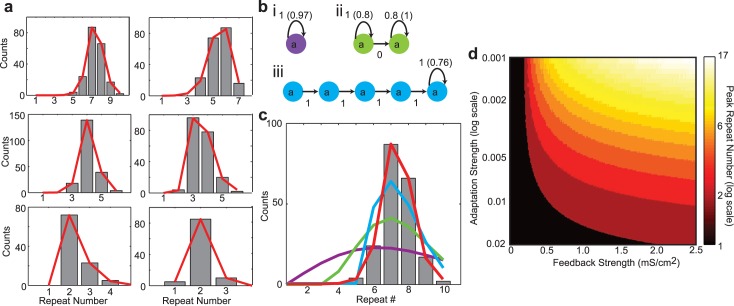
Sigmoidal adaptation model of repeats and model predictions.a: Six example repeat count histograms (black bars) from the neural network simulations with adapting auditory feedback and the best fit distributions from the sigmoidal adaptation model (red lines). The decay constants of the auditory feedback and the syllable lengths are varied to produce different repeat number distributions. Syllable lengths are changed by altering the number of groups per chain. All fit errors are smaller than benchmark errors. b: Best fit geometric adaptation models for the first histogram in a. With geometric adaptation, the probably of a state repeating is decreased by a constant factor with each consecutive repeat (Materials and Methods): (i) single state; (ii) two-states, both repeating; (iii) multiple-states, only final state repeating. In all cases, numbers on arrows are initial transition probabilities while the number in parenthesis is the constant adaptation factor. c: Comparison of model fits. Red is the best fit of the sigmoidal adaptation model with one state. Other colors are best fits of the corresponding models in b. The sigmoidal adaptation model provides a superior fit while only requiring a single state. d: Peak repeat number as a function of the initial auditory feedback strength and the adaptation strength generated using the sigmoidal adaptation model. The peak repeat number increases for increasing initial feedback strength and decreases for increasing adaptation strength. For a given adaptation strength, there is a threshold feedback strength at which repeat distributions become non-Markovian (i.e. peak repeat number > 1).